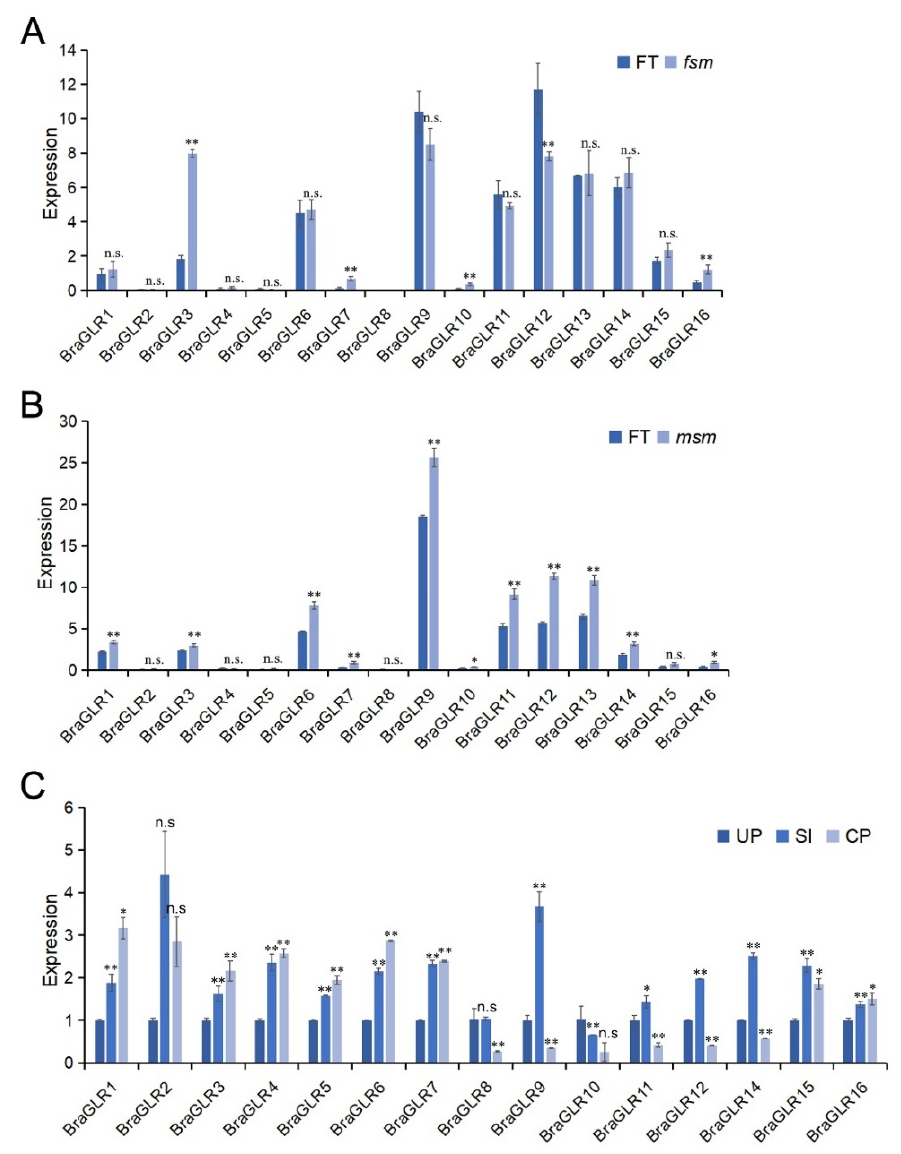
Figure 7. Analysis of sexual reproduction-related expression profiles of the GLR genes in B. rapa . ( A ) Analysis of female sterile mutant ( fsm ) and wild-type (FT) transcriptome data of GLR genes in B. rapa . ( B ) Analysis of male sterile mutant ( msm ) and wild-type (FT) transcriptome data of GLR genes in B. rapa . ( C ) Differential expression analysis of UP, SI, and CP. The stigmas of unpollinated, self-pollinated, and cross-pollinated B. rapa are denoted by UP, SI, and CP, respectively. (n.s., no significance, * p < 0.05, ** p < 0.01, t